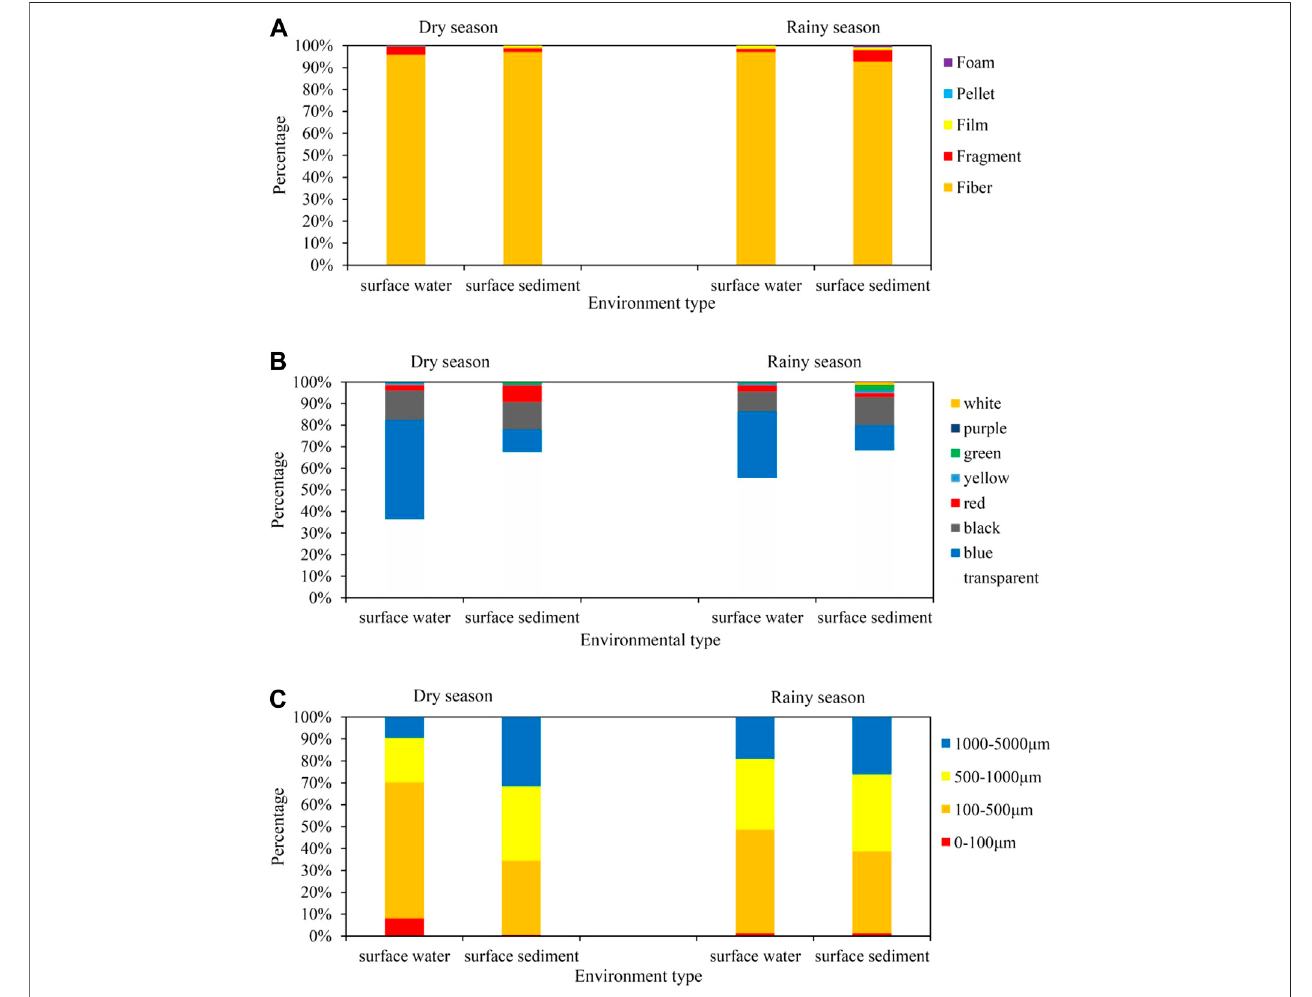
FIGURE5 | Relative proportion of different shapes (A) ,colors (B) , and sizes (C) of microplastics collected from the surface water and surface sedimentin the rainy and dry seasons.